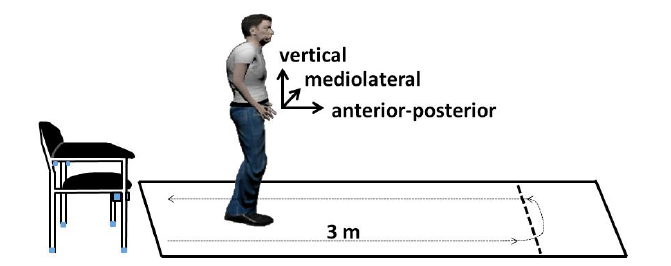
Figure 1. Setting of the Timed up and Go (TUG) test in our study. The test is measured by an IMU integrated into a belt. Additionally, a stopwatch and the automated/ambient TUG (aTUG) system are reference measures. The coordinate orientation of the Inertial Measurement Unit (IMU) is illustrated in the